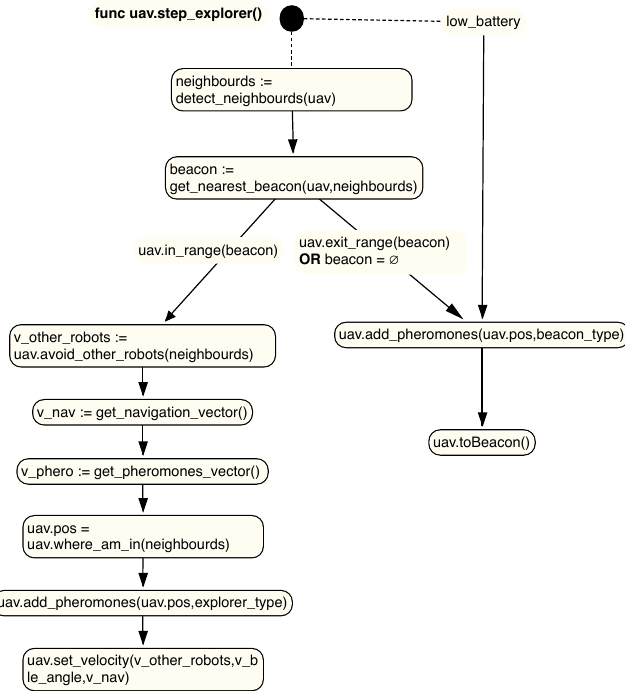
Figure 8. State diagram for the Sematectonic Pheromone Deployment (SEPHE) behavior of individuals of type active . In each processing step, any individual in this role will execute the steps listed in the